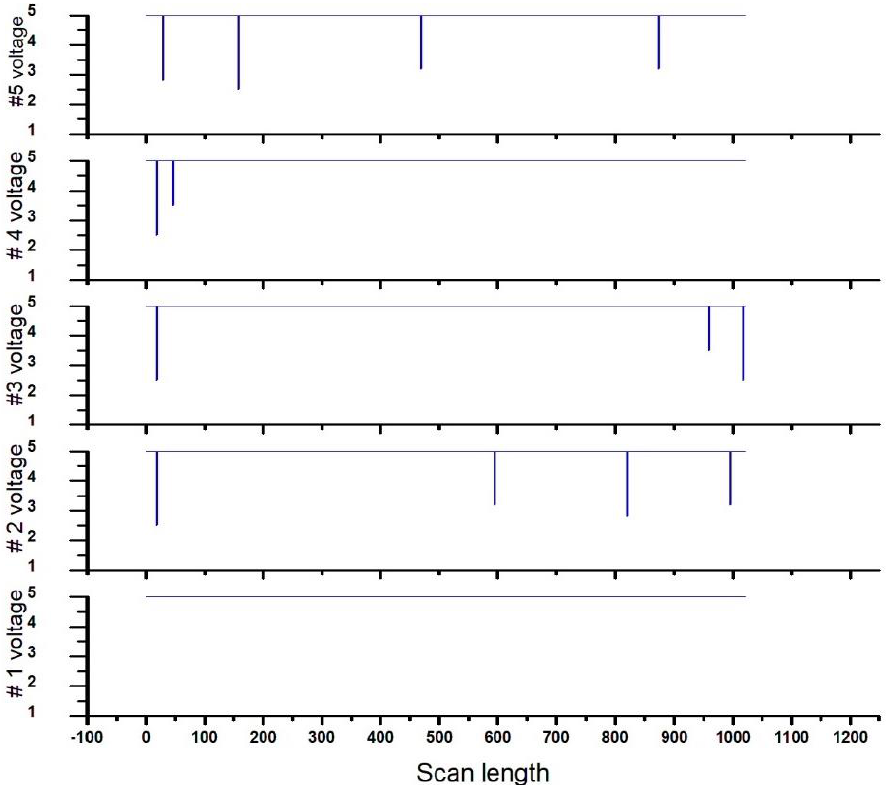
Figure 9. The profile of the laser sensor indicating the five sets of receivers. Moreover, the voltage for sensor #1 indicated the normal condition at 5 V. Sensors #2–5 intercepted the debris at 4, 3, 2, and 4. Accordingly, the voltage was below 3.5 V. The